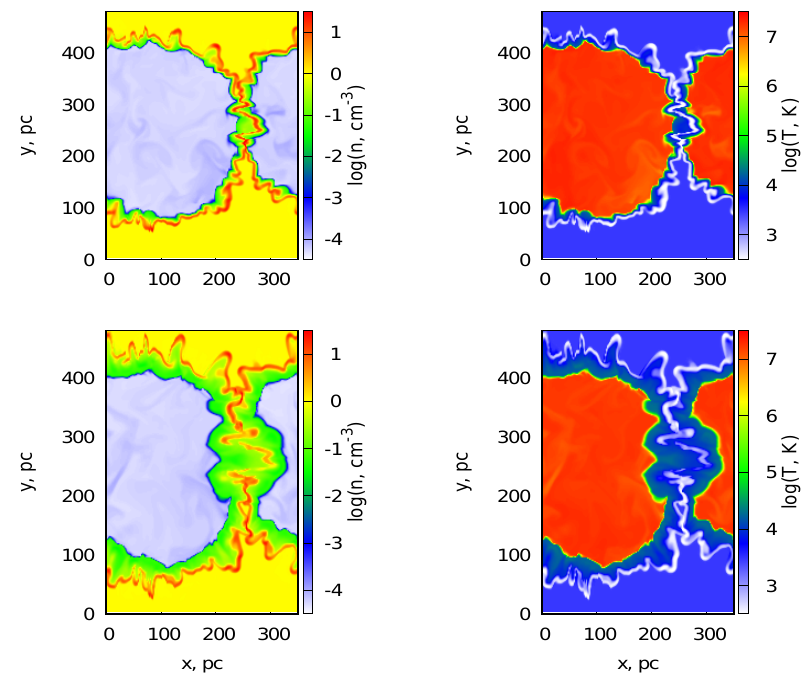
Figure 3. The density (left column) and temperature (right column) slices of the region, where two bubbles merge, at time moments 5.5 Myr (upper panels) and 7 Myr (lower panels). At the time of collision the age of each bubble is 4.3